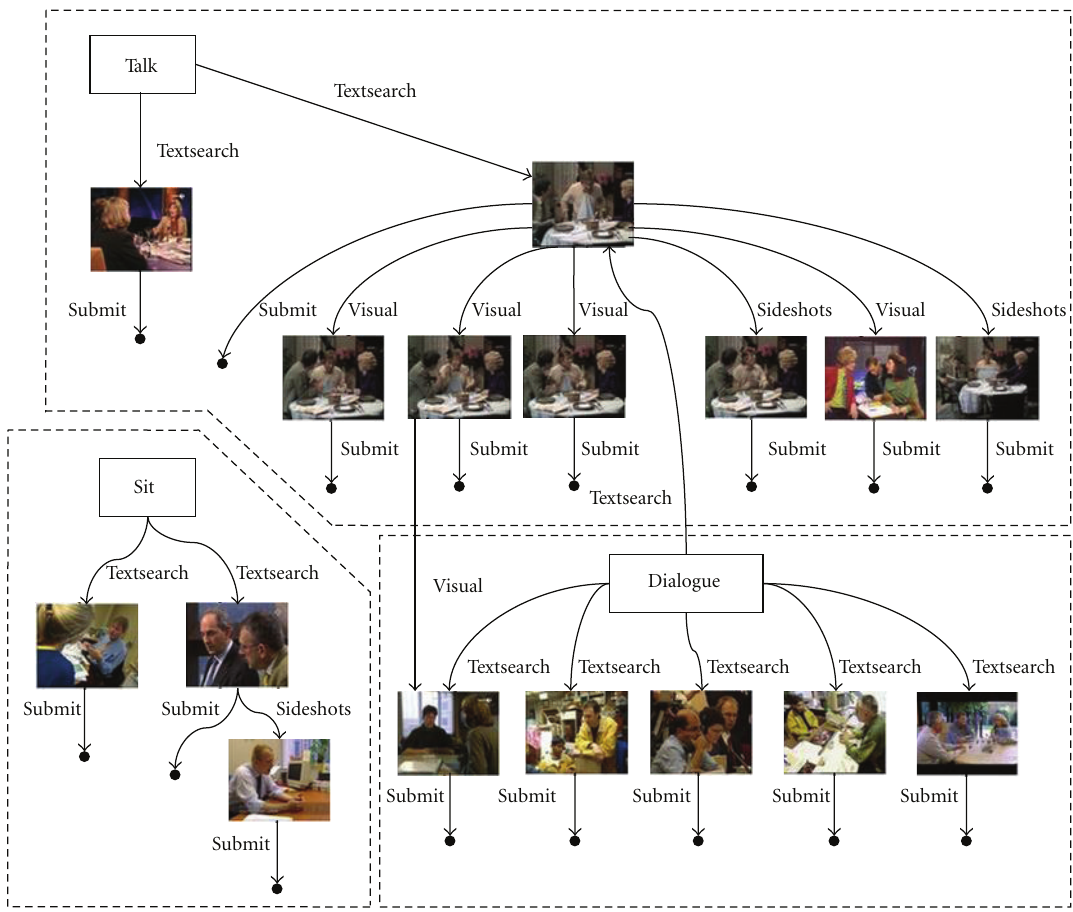
Figure 4: Action graph after user interaction.